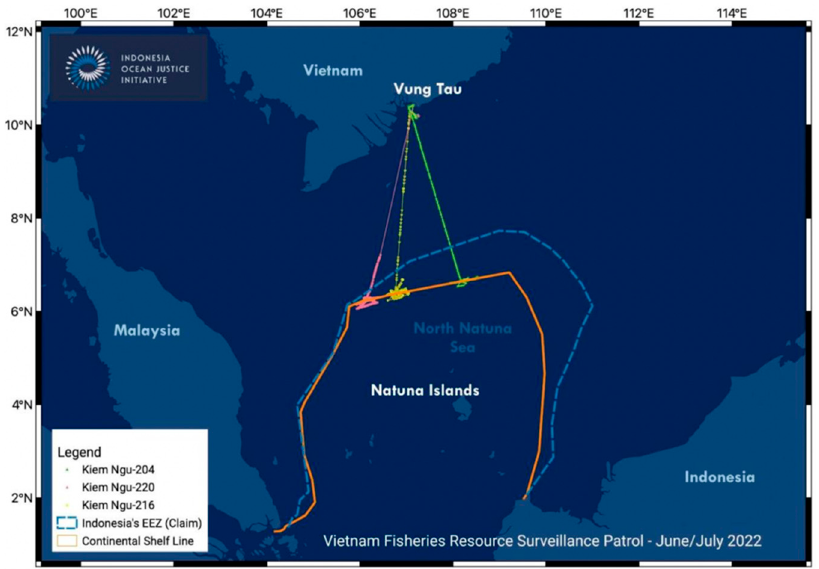
Figure 4. Track of VFRS between June and July 2022. Source: Indonesian Ocean Justice Initiative (IOJI 2022a).